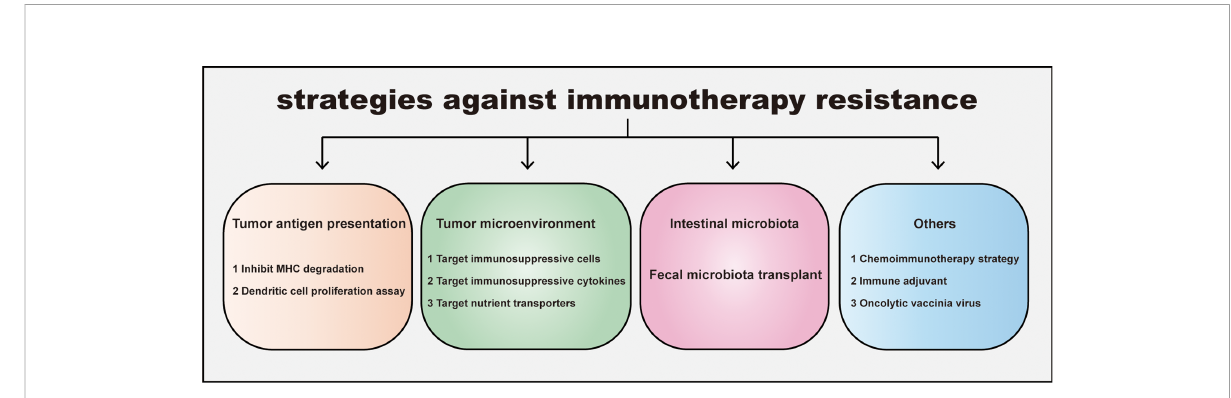
FIGURE 3 Strategies for overcoming immunotherapy resistance in CRC. The resistance leads to an ineffective immunotherapy and tumor progression. Four distinct strategies against immunotherapy resistance are listed: promoting tumor antigen presentation, regulating tumor immunosupprssive microenvironment, manipulating intestinal microbiota and others including combination therapy etc. Inhibiting MHC degradation and boosting dendritic cell proliferation could elevate tumor antigen presentation; Targeting immunosuppressive cells, cytokines in Tumor microenvironment (TME) and nutrient transporters help CD8+T escape the inhibition of TME. In addition, gut microbiota and its metabolite are widely proven to participate in tumor growth and immune response. Consistantly, fecal microbiota transplantation makes patients sensitive to immunotherapy. Other strategies for overcoming immunotherapy resistance, such as the administration of chemoimmunotherapy, immune adjuvant, oncolytic vaccinia virus can also improve the sensitivity of immunotherapy in